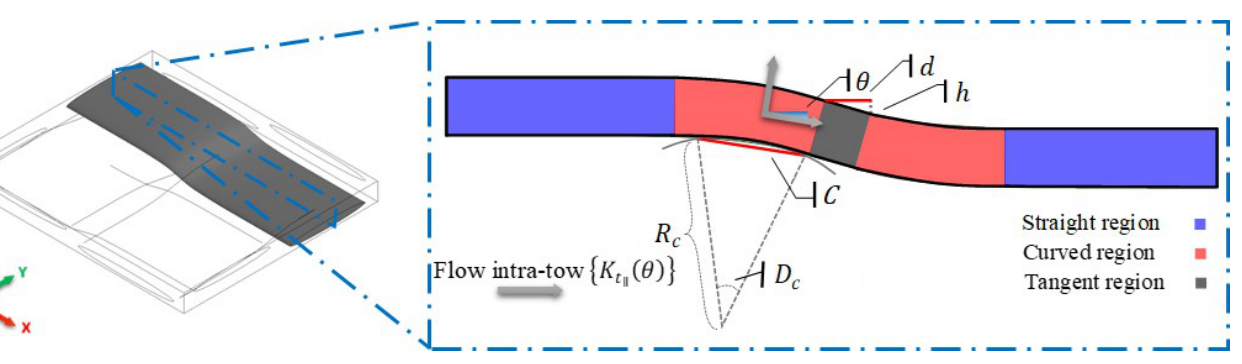
Figure 3. Schematic diagram for the intra-tow flow illustrating yarn curvature. Intra-tow porosity φ t is selected from low to high porous tows to investigate the influence on flows along fibres using, initially, the default porous model by ANSYS- Fluent in which Gebart’s model [35] is employed in viscous resistance formulation, 1/ K t , for parallel, K , and perpendicular, K t ⊥ , intra-tow permeabilities. The same manner is t (cid:107) adopted for the UDF case with exception to the parallel K intra-tow permeability as it is t (cid:107) controlled by an algorithmic code based on degree of curvature and relevant equations. In straight tows, K is a function of R f and φ t , but K becomes a function of R f , φ t and θ in t (cid:107) t (cid:107) curved and inclined tows. Wherein K t ⊥ , flow is acting almost the same in both straight and curved tows, as it is propagating perpendicularly to fibres and that would show identical